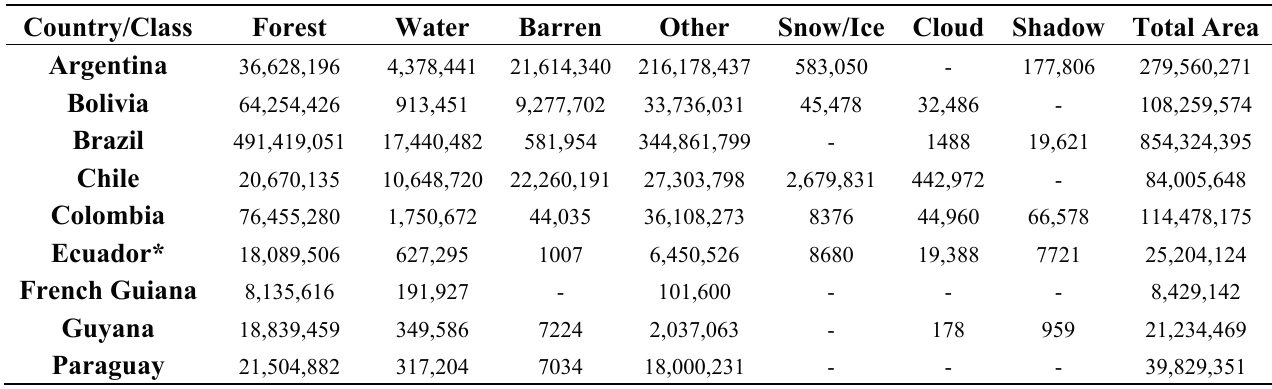
Table 1. Land cover extent of South American countries prepared using Landsat 30 m data of 2010 (in